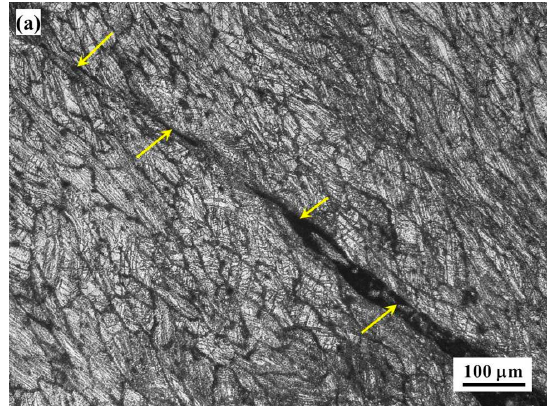
Figure 8. ( a ) Flow stress vs. strain rate, and ( b ) normalized flow stress vs. reciprocal of absolute temperature for ZX11